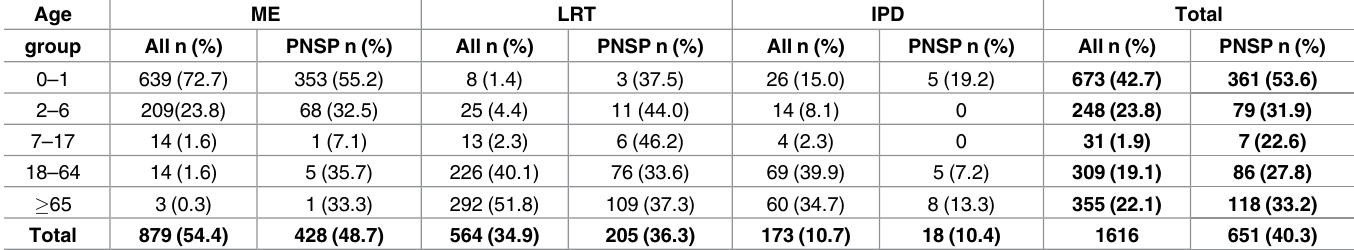
Table 1. Distribution of all isolates and PNSP isolates according to sampling site and age of the patient and their proportions (%) within age group and sampling site.